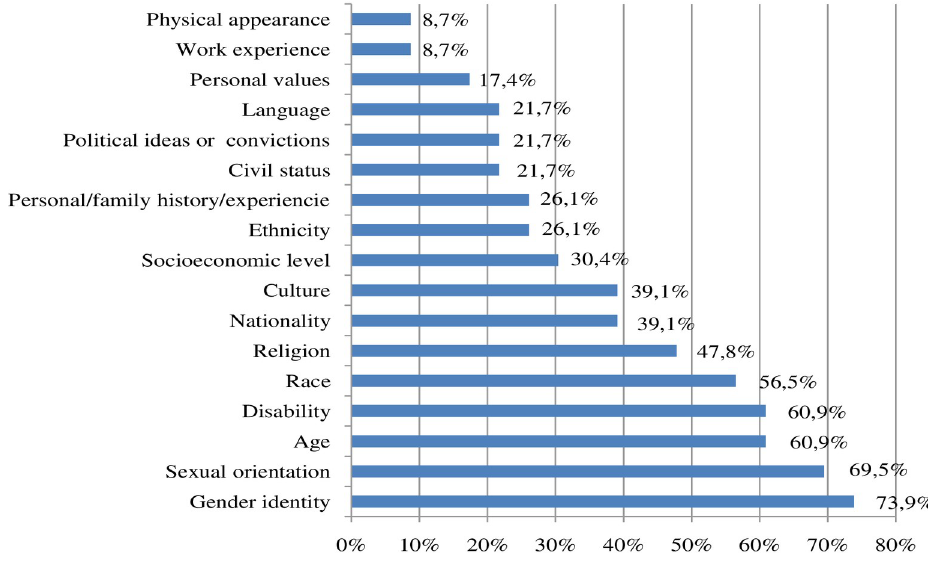
Fig 6. Distribution of frequency coding according to the concept of